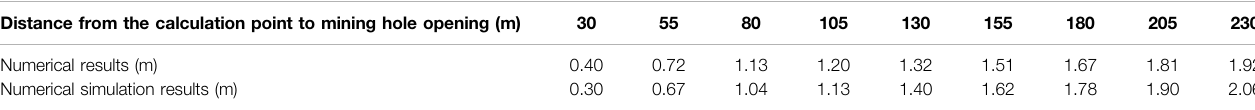
TABLE 15| Inelasticzonewidthofthecoalpillarcalculatedbynumericalcalculationandnumericalsimulation underthe100% fi llingrateconditionoftheWestBokaro open- pit mine. Distance from the calculation point to mining hole opening